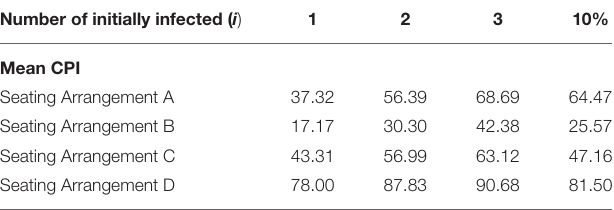
TABLE 2 | CPI for the four seating arrangements with transmission rate γ = 0.05.